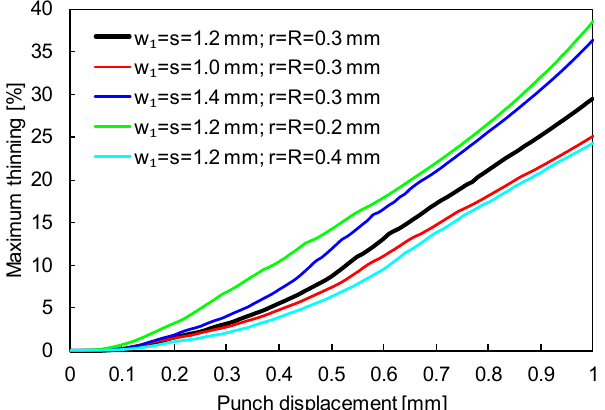
Figure 12. Evolution of the maximum thinning in the channel with the punch displacement for three values of channel/rib width and three values of punch/die fillet radius (plane strain conditions).